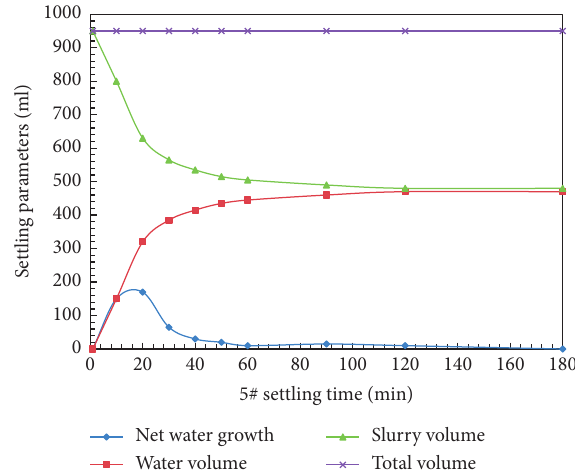
Figure 11: Flocculating sedimentation test parameters of tailings (#5).